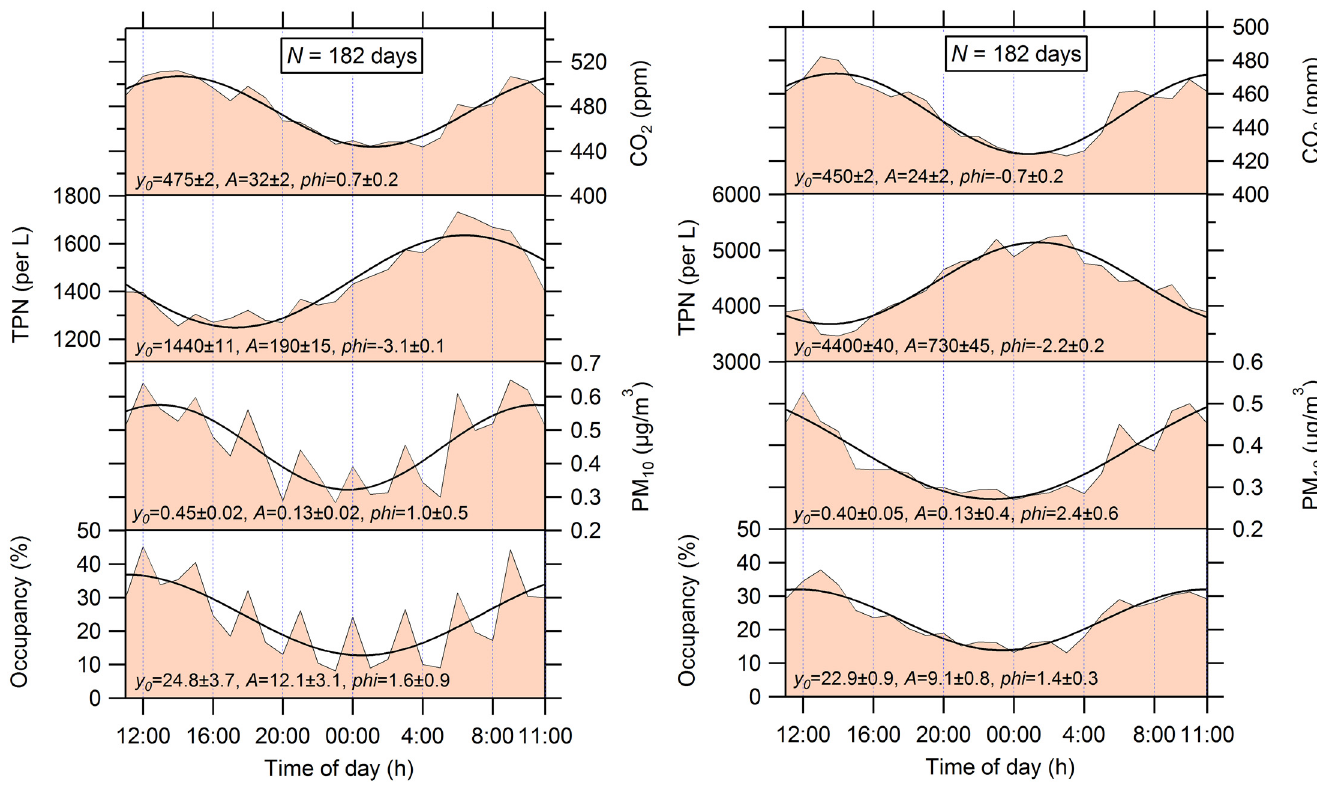
Fig 4. Daily 1-h mean concentrations of CO 2 , total particle number (TPN), PM 10 mass and human occupancy over the full monitoring period measured in all baby rooms (left) and in the hallway (right). A least-squares best-fit sinusoidal curve (Eq 1) is shown along with function coefficients and standard